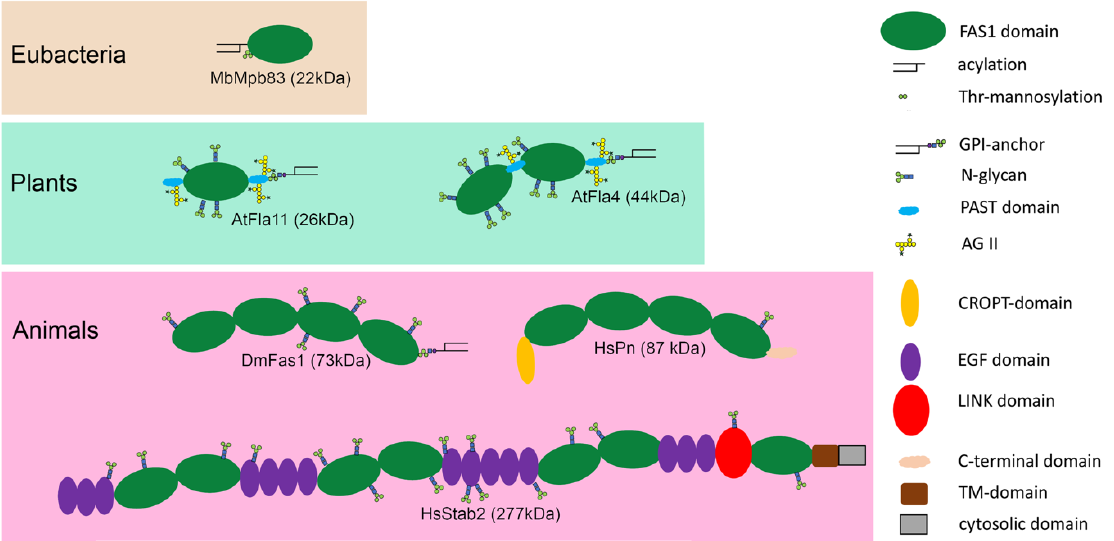
Figure 3. Domain organization and post translational modifications of six representative FAS1 proteins discussed in this article. Proteins are shown with their N-termini on the left. As opposed to the C-terminally attached GPI-anchors Mpb83 is acylated near its N-terminus. Note that the annotation of AG II glycosylation is tentative and that the annotation of N- glycans is based on bioinformatic predictions. Abbreviations used in this Figure, GPI: glycosylphosphoinositidyl; TM: transmembrane; AG II: arabinogalactan type II; CROPT: Cysteine-Rich domain of Pn and TGFBIp; EGF: epidermal growth factor; PAST: domain rich in Pro, Ala, Ser and Thr.